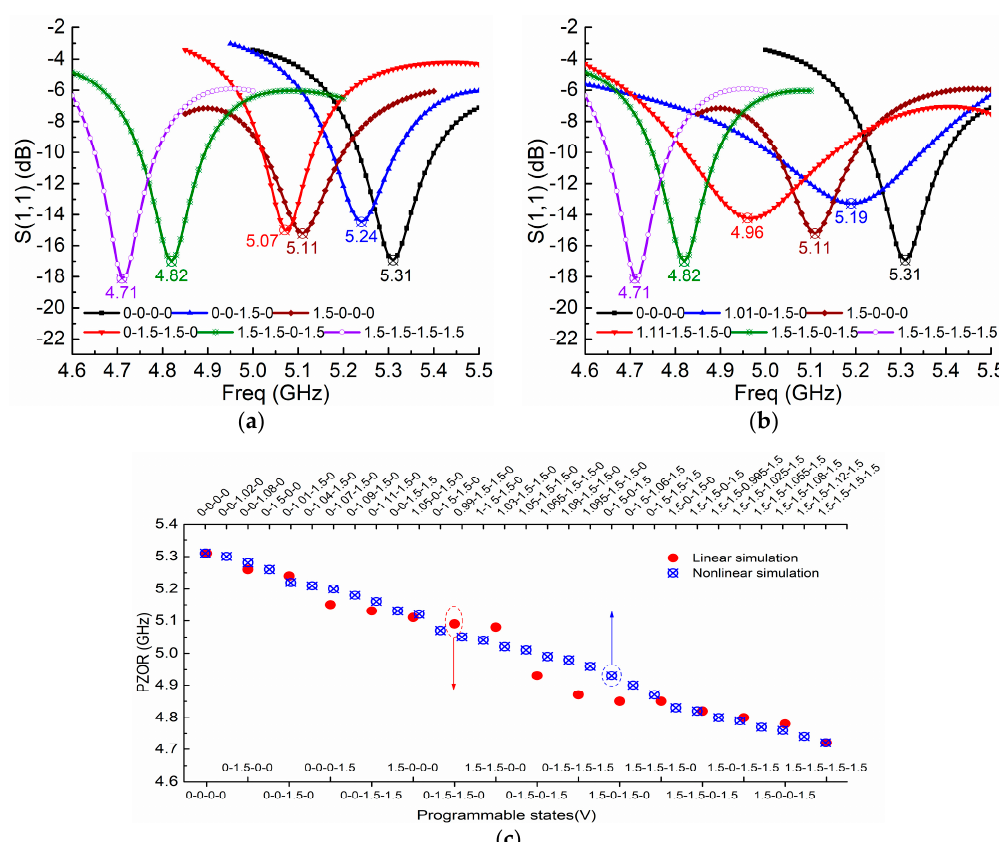
Figure 6. Simulation results of S11 with co-simulation method using PIN diode model as RF switch: ( a ) 6 linear states; ( b ) 6 nonlinear states with uniform tuning; and ( c ) ZOR comparisons of all 16 linear states with 30 nonlinear states.